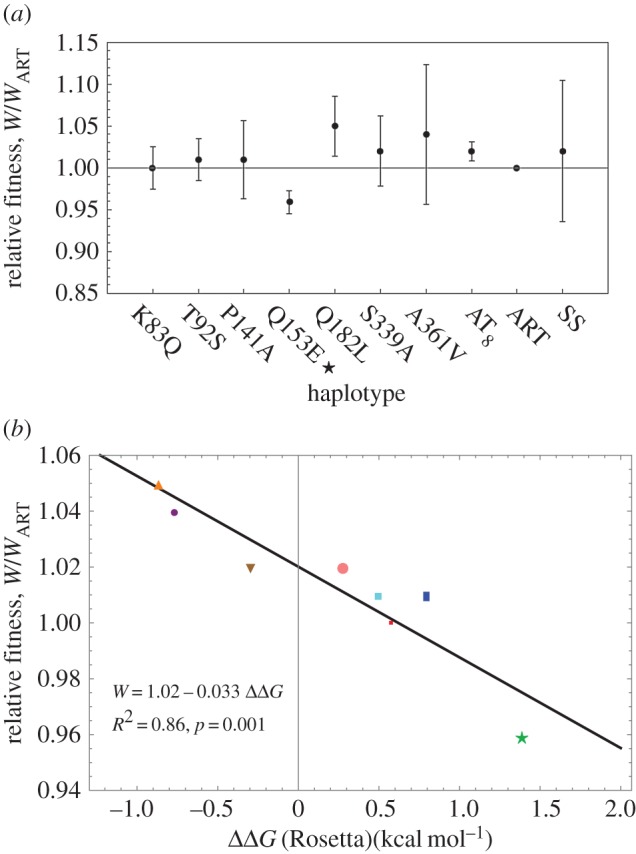
(a) Experimental fitness measures (relative to ART). Bars: 1 s.d. on each side. None of the haplotypes have a fitness significantly different from the SS. Star denotes consensus of the extant species. (b) Relationship between relative fitness and ΔΔGR. Small red square, K83Q; magenta square, T92S; blue rectangle, P141A; green star, Q153E (consensus); orange upright triangle, Q182L; brown downwards triangle, S339A; small purple bullet, A361V; large pink bullet, AT8. (Online version in colour.)